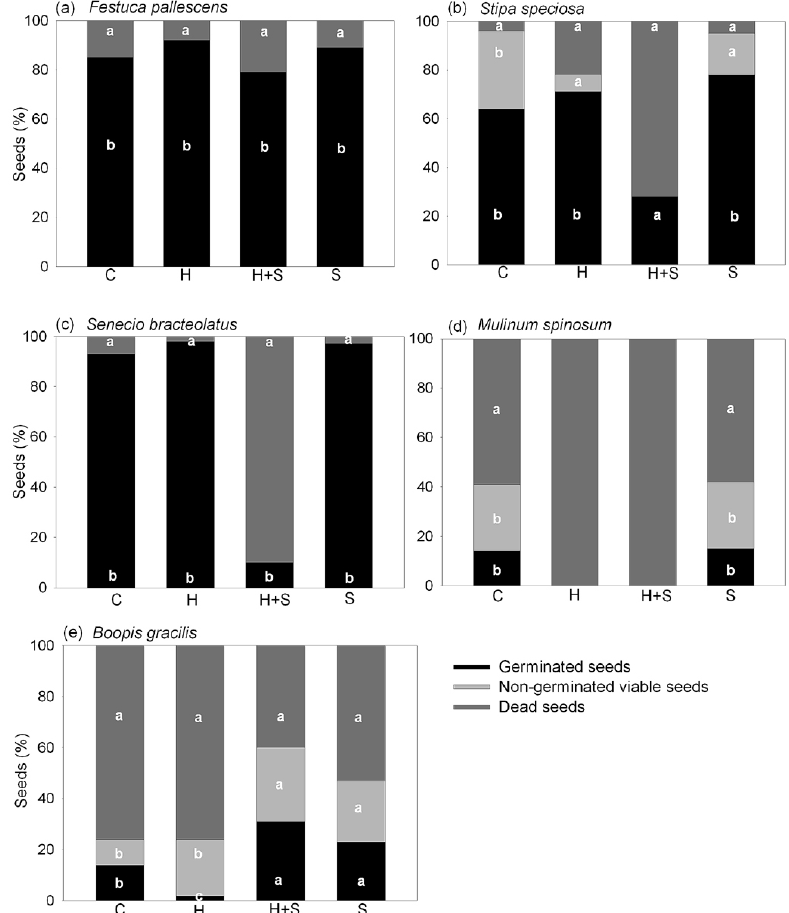
Fig. 2. Percentage of germinated seeds, dormant (ungerminated but viable seeds), and dead seeds according to the tetrazolium chloride test in the treatments: C (Control), H (Heat at 80 ◦ C for 5min), H+S (Heat+Smoke), S (Smoke for 60min) for (a) Festuca pallescens (b) Stipa speciosa (c) Senecio bracteolatus (d) Mulinum spinosum , and (e) Boopis gracilis . Different letters indicate significant differences among condition of the seeds within each